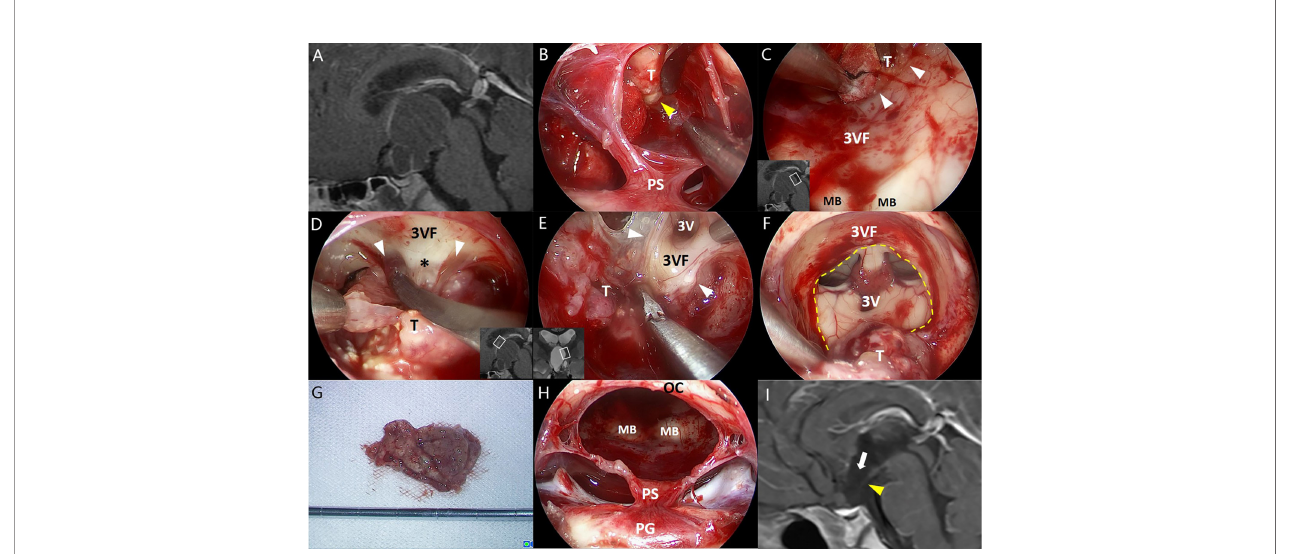
FIGURE 2 | Illustrative endonasal case 2 clarifying the tumor – ventricle relationship. In (A) , a CP with predominantly ventricular involvement was identi fi ed on preoperative MRI. In (B) , the thin layer of pars tuberalis was incised longitudinally and careful dissection was performed along the tumor – infundibulum interface (yellow arrowhead) to preserve the continuity of the stretched pituitary stalk. In (C) , a cleavage pial plane (white arrowhead) ensured the successful dissection of the tumor and the integrity of adjacent third ventricle fl oor remained. In (D) , the pia mater was absent at some areas of the tumor – ventricle interface, while a layer of reactive gliosis (asterisk) could provide a safe cleavage plane for surgical dissection instead. In (E) , a clear boundary between the tumor and the third ventricle fl oor was observed at the lateral folder of the third ventricle, although partial remnants of the third ventricle fl oor was removed with the tumor due to the dense adhesion. In (F) , most portions of the tumor capsule were dissected with an opening left at the third ventricle fl oor (dashed line). In (G) , the tumor was removed en bloc after dissection. In (H) , the stretched thin layer of the pituitary stalk was mostly preserved after tumor removal. In (I) , postoperative MRI reveals the defect of anterior third ventricle fl oor (white arrow) and the stretched thin pituitary stalk (yellow arrowhead). 3V, the third ventricle; 3VF, the third ventricle fl oor; MB, mamillary body; OS, optic chiasm; PG, pituitary gland; PS, pituitary stalk; T,